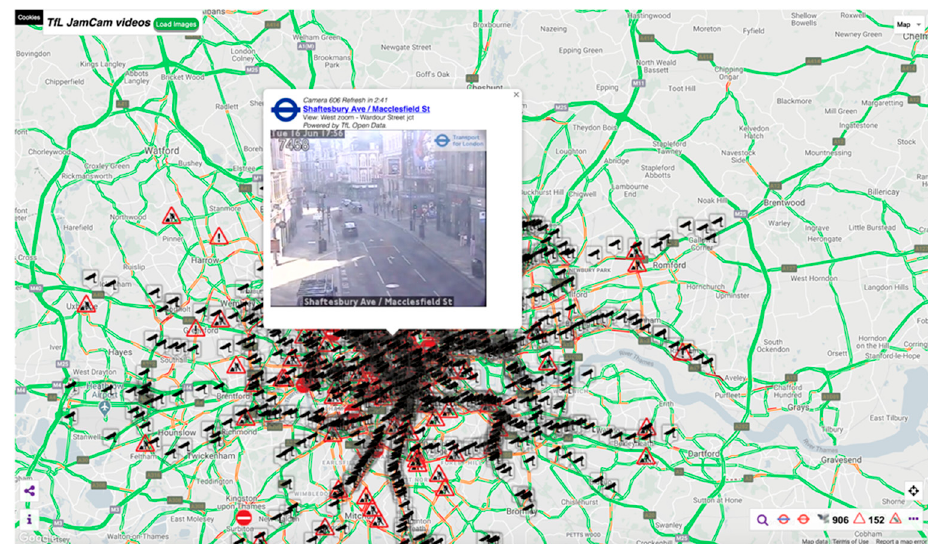
Figure 1. Example of a website providing access to traffic camera data streams provided by the local government body Transport for London via their JamCam open data service (screenshot from https://www.tfljamcams.net (accessed on 28 June 2021) data © 2021 Google; Contains OS data © Crown copyright and database rights 2021 and Geomni UK Map data © and database rights 2021).